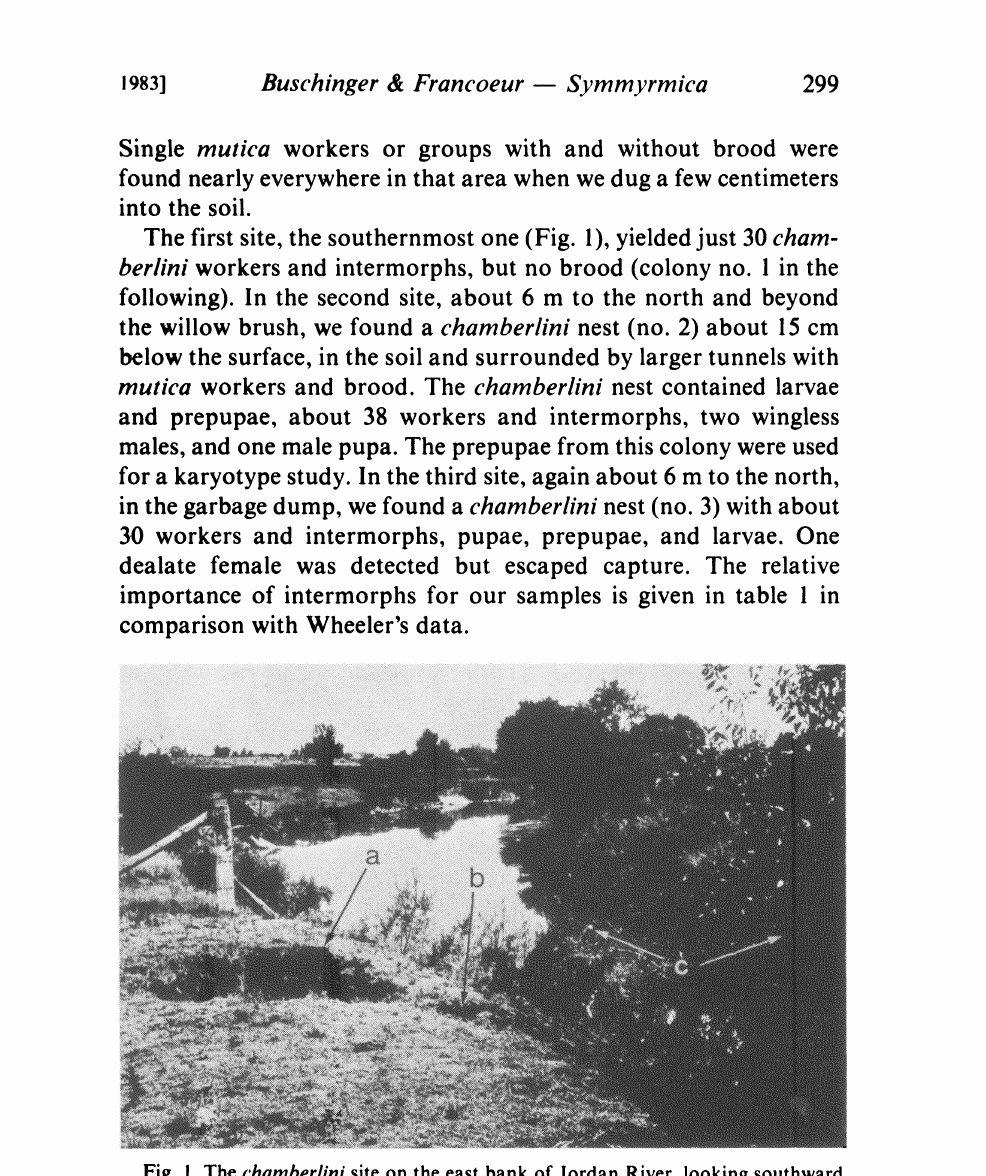
Fig. I. The chamberlini site on the east bank of Jordan River, looking southward (upriver). a) Site of chamberlini colony no. within a Manica colony b) Site of another Manica colony which extended along the willow brush to the right c) willow brush between chamberlini colonies and